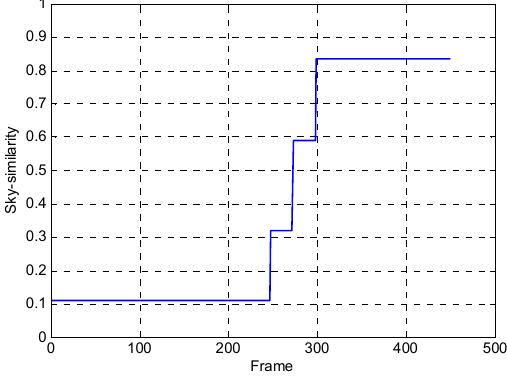
Figure 13. The sky similarity varies with the frames.